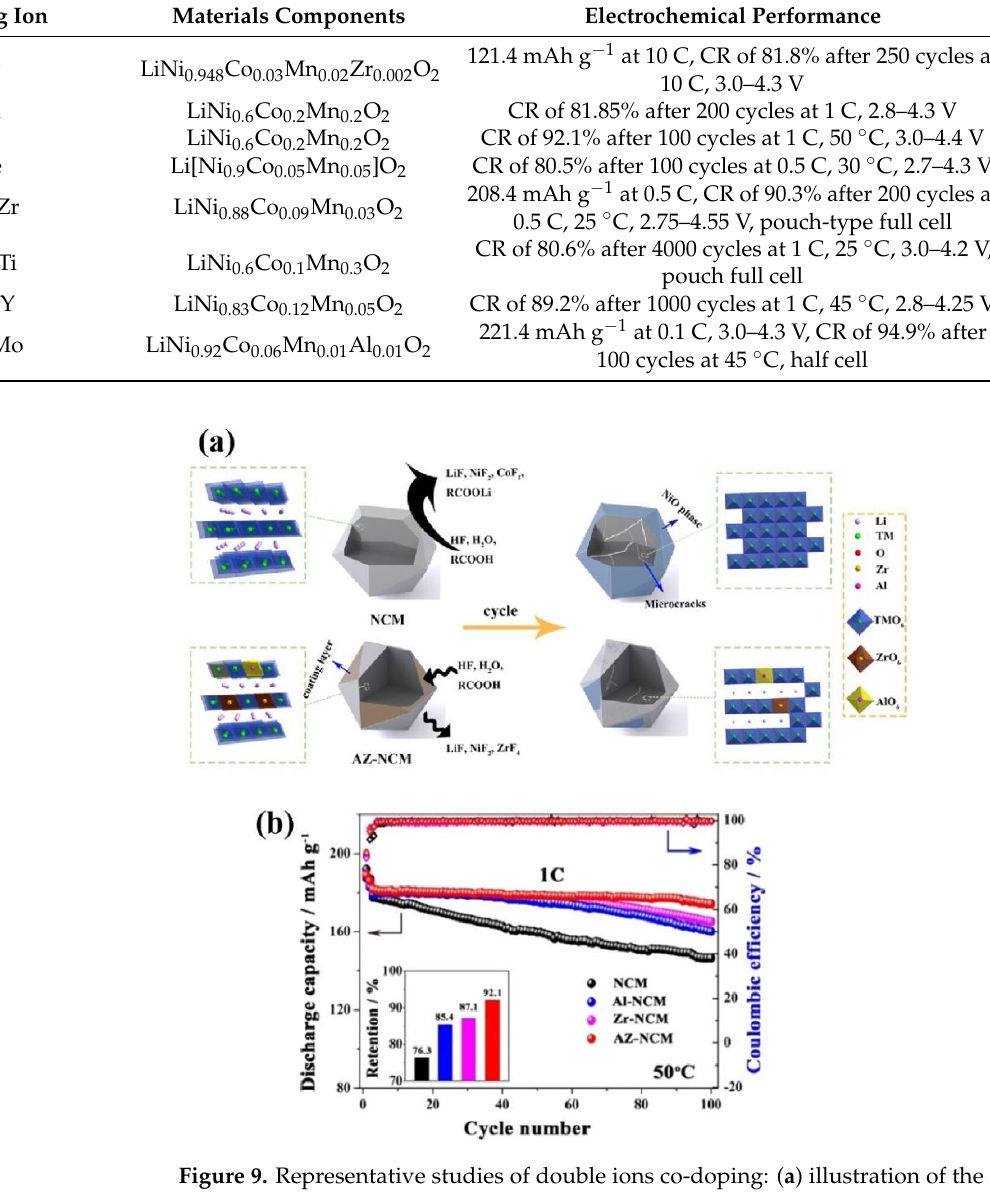
Figure 9. Representative studies of double ions co-doping: ( a ) illustration of the Al/Zr co-doping mechanism and ( b ) cycling performance for AZ-NCM. Reproduced from Ref. [275], Copyright 2021, American Chemical Society.